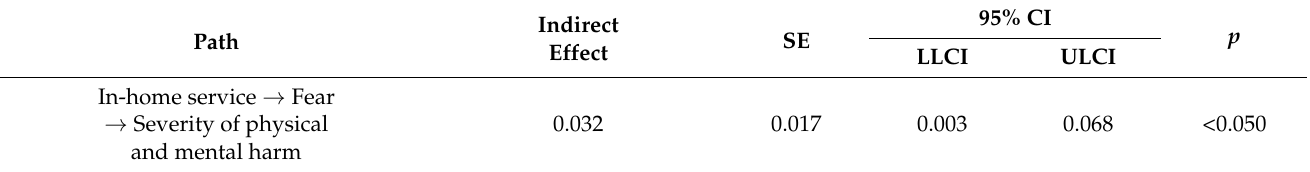
Table 3. Indirect effect of independent variable on the severity of physical and mental harm.